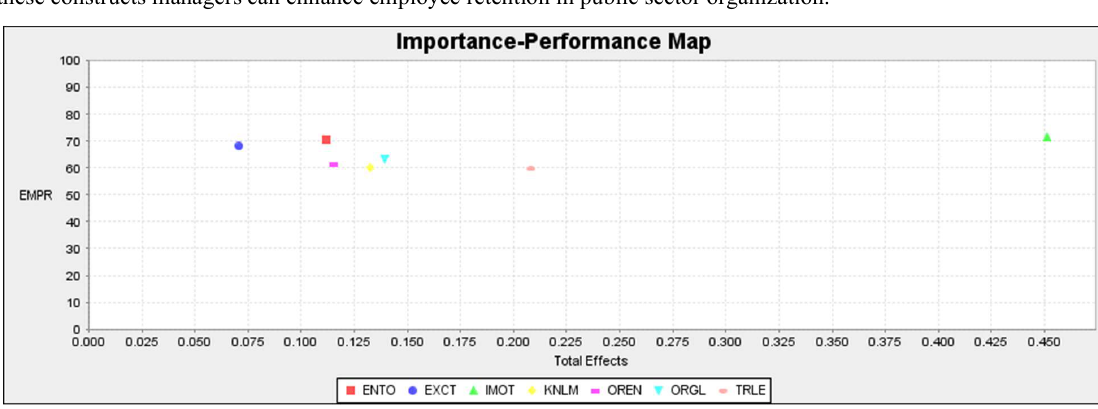
Fig. 2. Importance performance matrix analyses